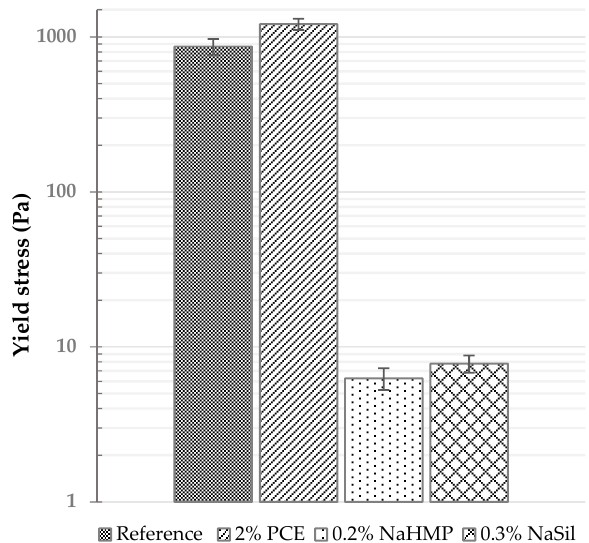
Figure 4. Comparative yield stress of earth pastes mixed with different dispersants.